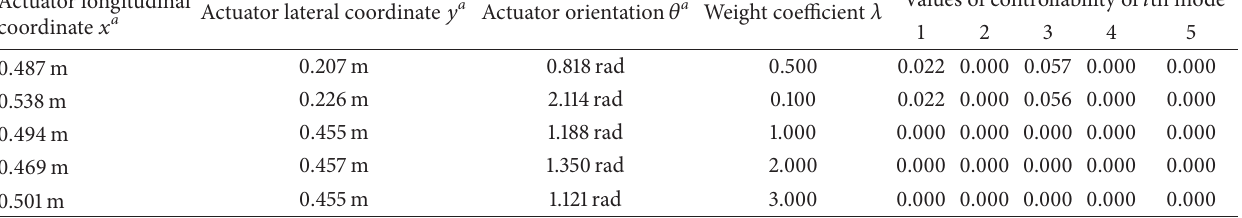
Table 5: The effect of values of the weight coefficients on the controllability for a single actuator for the case that only the first mode is controlled.